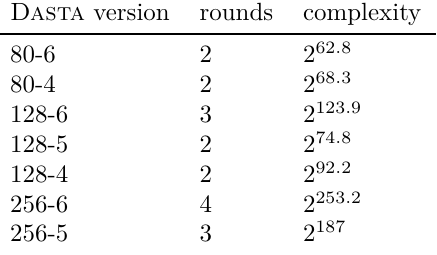
Table 2: Linearization